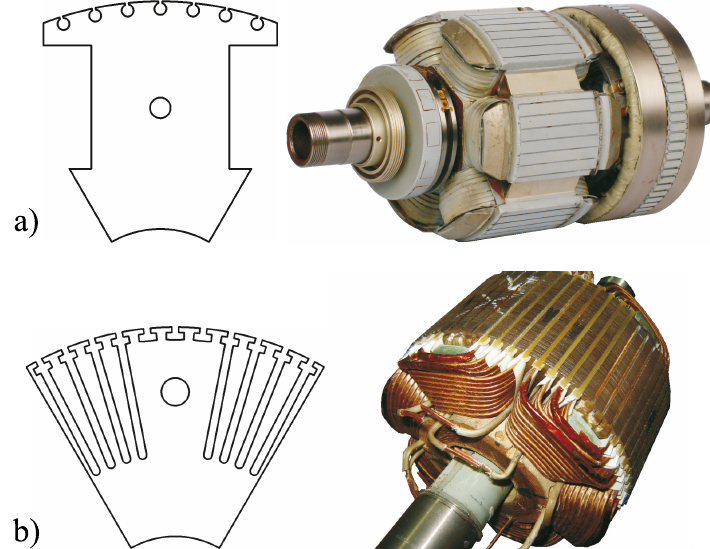
Figure 2. Two types of exciter of the main generator: ( a ) salient pole (original commercial structure, exciter, and subexciter on one shaft); ( b ) non-salient pole (prototype structure, exciter, and subexciter temporally removed from the